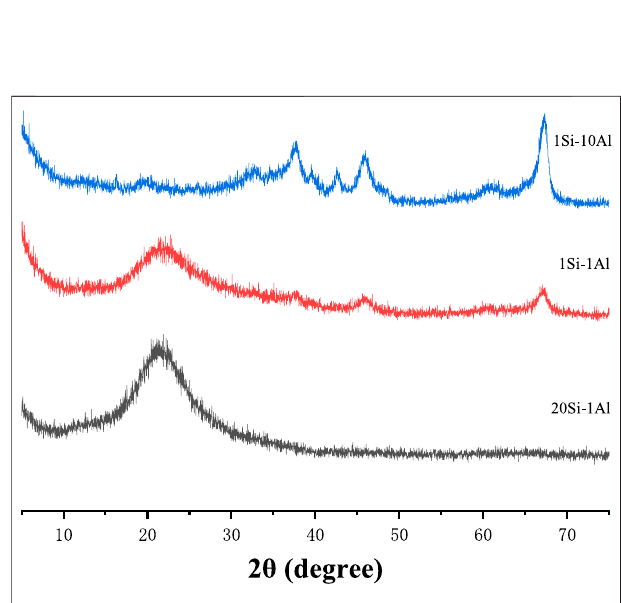
FIGURE4| XRDpatternsofmineralpolymericprecursorswithdifferentaluminumsources. (A) :aluminumchloridehexahydrate; (B) :aluminumnitratenonahydrate.